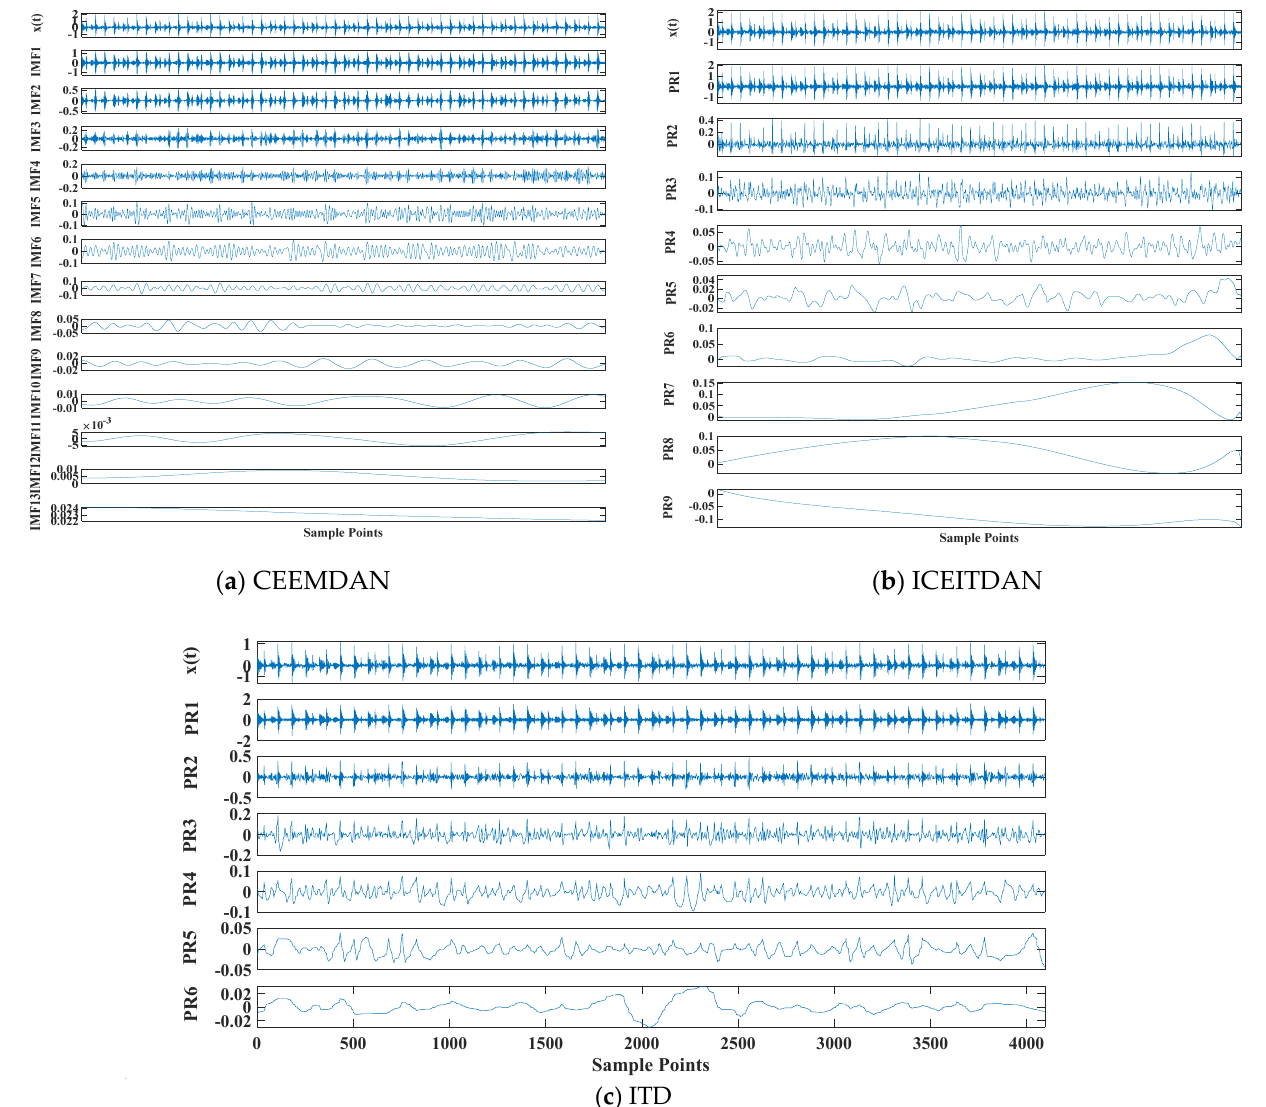
Figure 3. Comparison chart of the decomposition results of three methods: Complete ensemble empirical mode decomposition with adaptive noise (CEEMDAN), improved complete ensemble intrinsic time-scale with adaptive noise (ICEITDAN), and intrinsic time decomposition (ITD). ( a ) CEEMDAN, ( b ) ICEITDAN, and ( c ) ITD.